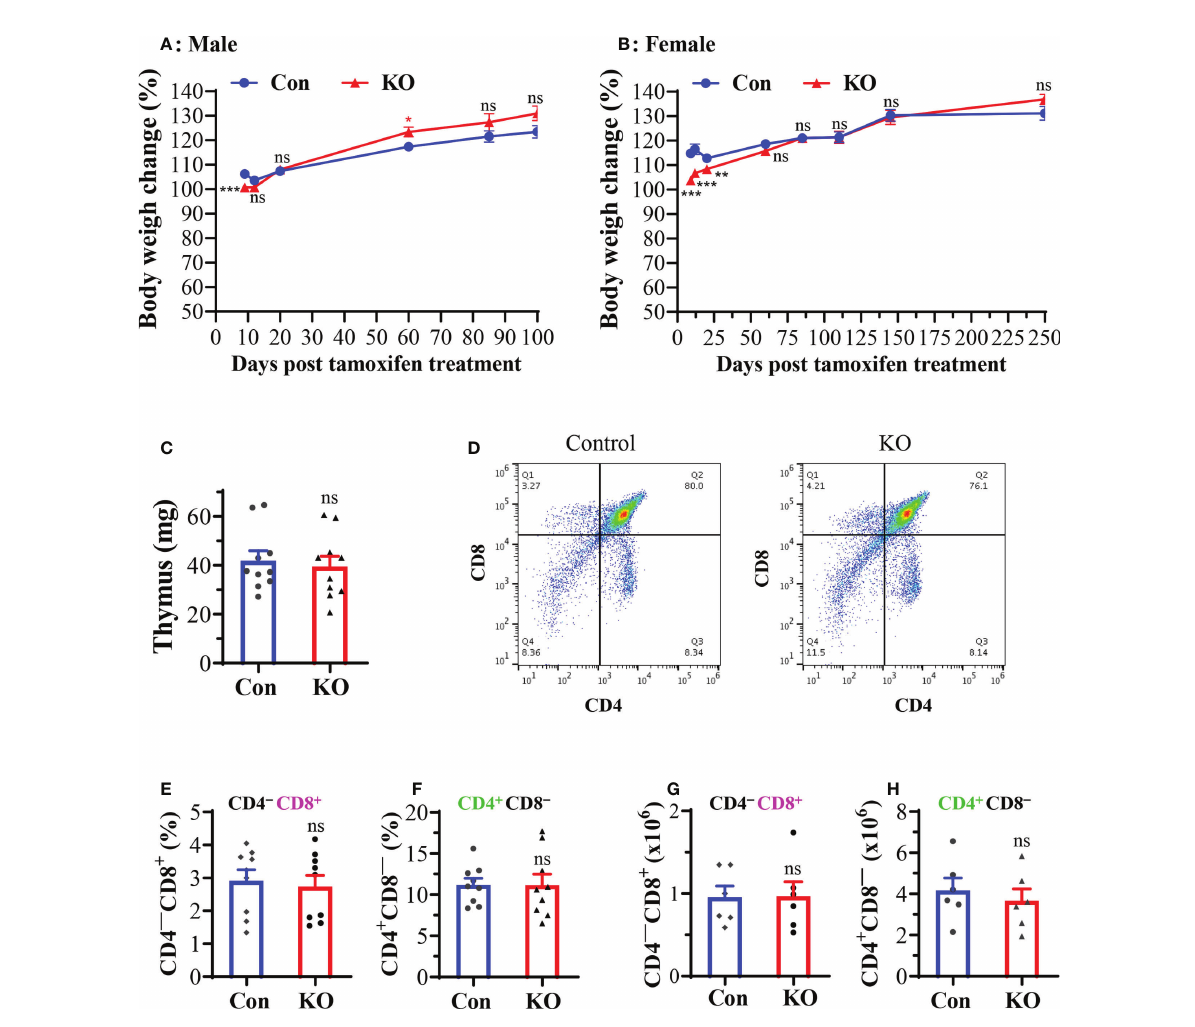
FIGURE 2 A general Runx3 KO in adult mice has a minor effect on animal survival and thymic T cell generation under normal conditions. (A, B) Body weight changes in age-matched male (A) and female (B) littermate control (Con) and Runx3 KO mice after tamoxifen treatment. Mouse body weights were measured from days (D) 9 to d250 post last tamoxifen treatment, and relative changes were calculated by comparison to the initial body weight before tamoxifen treatment and are presented as means ± SE (n = 6 to 22 each group). In panel A: d9 to d20, n=19-22; d60 to d100, n=8-13. In panel B: d9 to d145, n = 12-16; d250, n = 6. (C – H) Runx3 KO in adult mice has a minor effect on thymic function. (C) Thymus weights of control and Runx3 KO mice (n = 10 each group) (D) Representative thymic FACS plots evaluated one month after tamoxifen treatment are shown for control and Runx3 KO mice. (E – H) The cell frequencies and absolute numbers of single CD8 + (E, G) or CD4 + (F, H) positive T cells in thymus are shown in the bar graphs. Results are presented as means ± SE (n = 6-9). Unpaired Student ’ s t test was performed in (A – H) . *p<0.05; **p<0.01; ***p<0.001 vs control mice. NS, not statistically signi fi